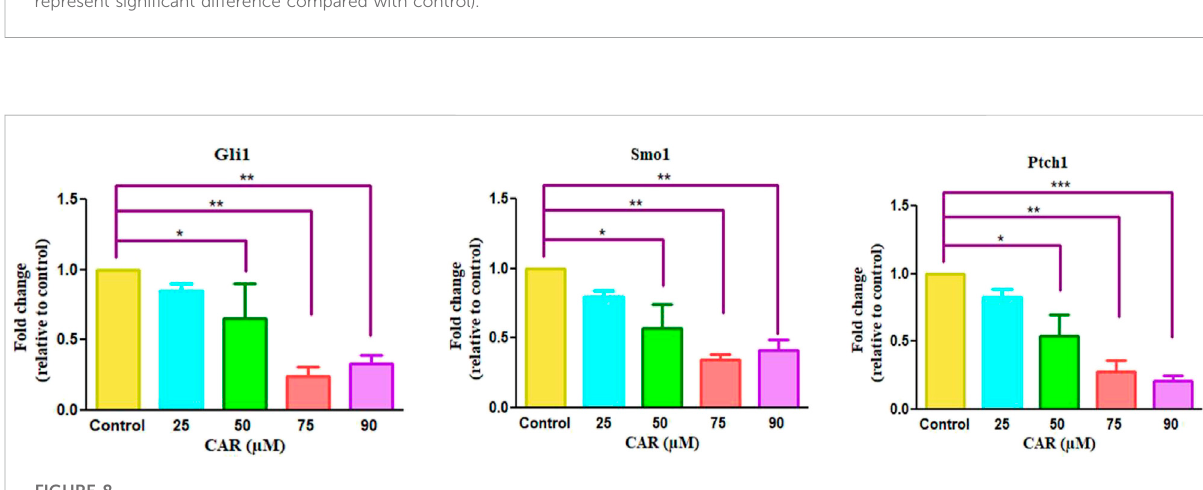
FIGURE 8 Effect of CAR on mRNA expression of key components of HH signaling pathway in cervical carcinoma cells. The graphs show fold change in mRNA expressionofGLI1, SMO1 and PTCH1relativeto control inC33A cells after treatment with CAR(25 – 90 µM) as measured by qPCRusing SYBR Green dye. Target gene expression is normalized to GAPDH mRNA expression and the results are expressed as fold change from control. Data reported are mean ± SEM of three separate experiments each of which were performed in triplicates. Signi fi cant difference among the treatment groups were analyzed by two tailed Paired Student ’ s t-test and one-way ANOVA followed by Dunnett post hoc test (* p < 0.05 , ** p < 0.01 , *** p < 0.001 represent signi fi cant difference compared with